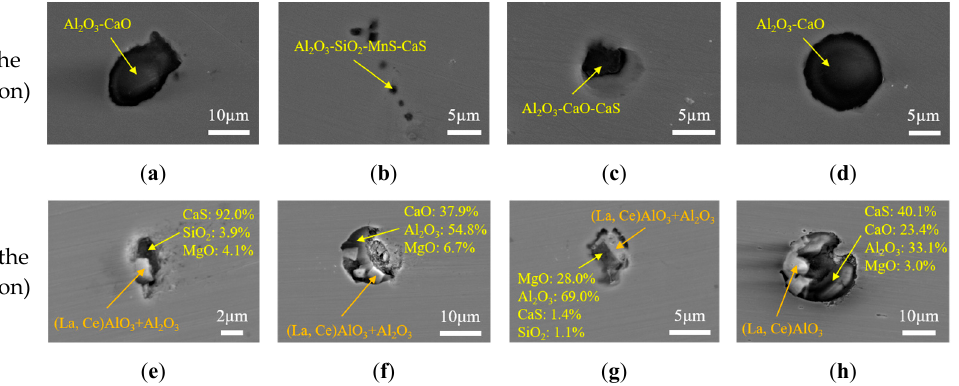
( h ) Figure 10. Morphologies and compositions of inclusions, before and after rare earth treatment, after RH alloying . ( a ) Al 2 O 3 -MgO; ( b )MgO-Al 2 O 3 -MnO; ( c ) Al 2 O 3 -MgO; ( d ) Al 2 O 3 -MgO-MnS; ( e ) (La,Ce)AlO 3+ Al 2 O 3 -CaO-CaS; ( f ) (La,Ce)AlO 3+ Al 2 O 3 - MgO-CaO; ( g ) (La,Ce)AlO 3+ Al 2 O 3 - MgO-CaO; ( h ) Al 2 O 3 - MgO-CaO Figure 11 shows the morphologies and compositions of typical inclusions in the steel before and after rare earth treatment, after the RH refining station. The majority of inclusions at the RH station are composed of Al 2 O 3 -CaO, with some inclusions containing